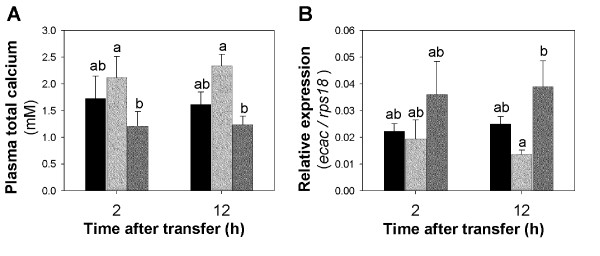
Blood plasma total calcium and ecac gill mRNA expression upon exposure to different water [Ca2+]. Each bar is the mean ± S.E.M of (A) the plasma total calcium levels (mM) and (B) the relative expression of the epithelial calcium channel mRNA in the gills (ecac expression quantified by qPCR and normalized to the reference gene rps18) of T. nigroviridis individuals (n = 5-6/group) after 2 or 12 h transfer to 10 ppt artificial water containing 2.9 mM Ca2+ (control water, black bars), 10 mM Ca2+ (HighCa water, light grey bars) or 0.01 mM Ca2+ (LowCa water, dark grey bars). Different letters indicate statistically significant differences (p < 0.05) between groups, evaluated by two-way ANOVA.